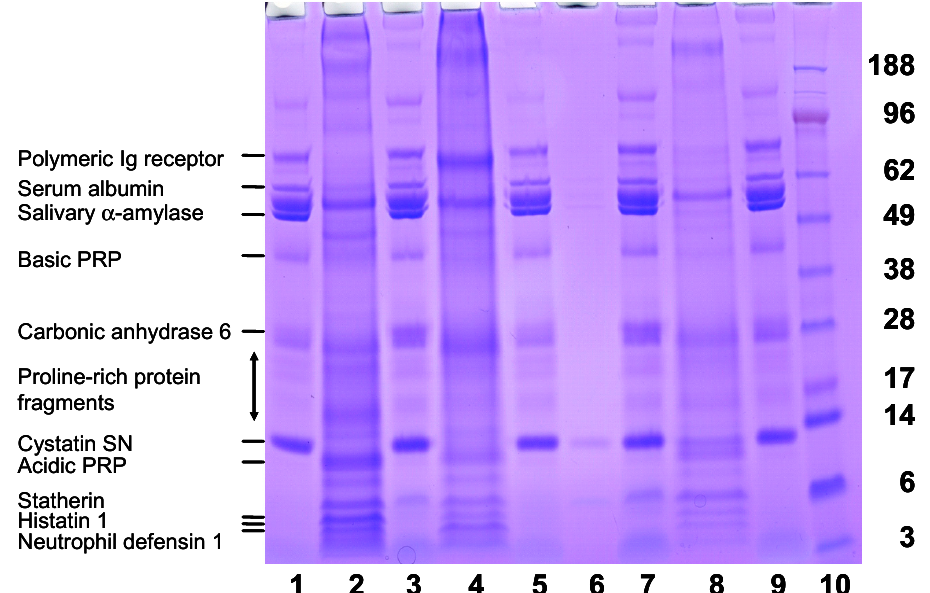
Figure 2. SDS-PAGE profile of salivary proteins derived from whole saliva (WS) bound to casein phosphopeptides (CPP)-coated or uncoated HA. Lane 1: Salivary proteins not bound to β -CN (1–25). Lane 2: Salivary proteins bound to β -CN (1–25). Lane 3: WS. Lane 4: Salivary proteins bound to α S1 -CN (59–79). Lane 5: Salivary proteins not bound to S1 -CN (59–79). Lane 6: WS diluted 1 in